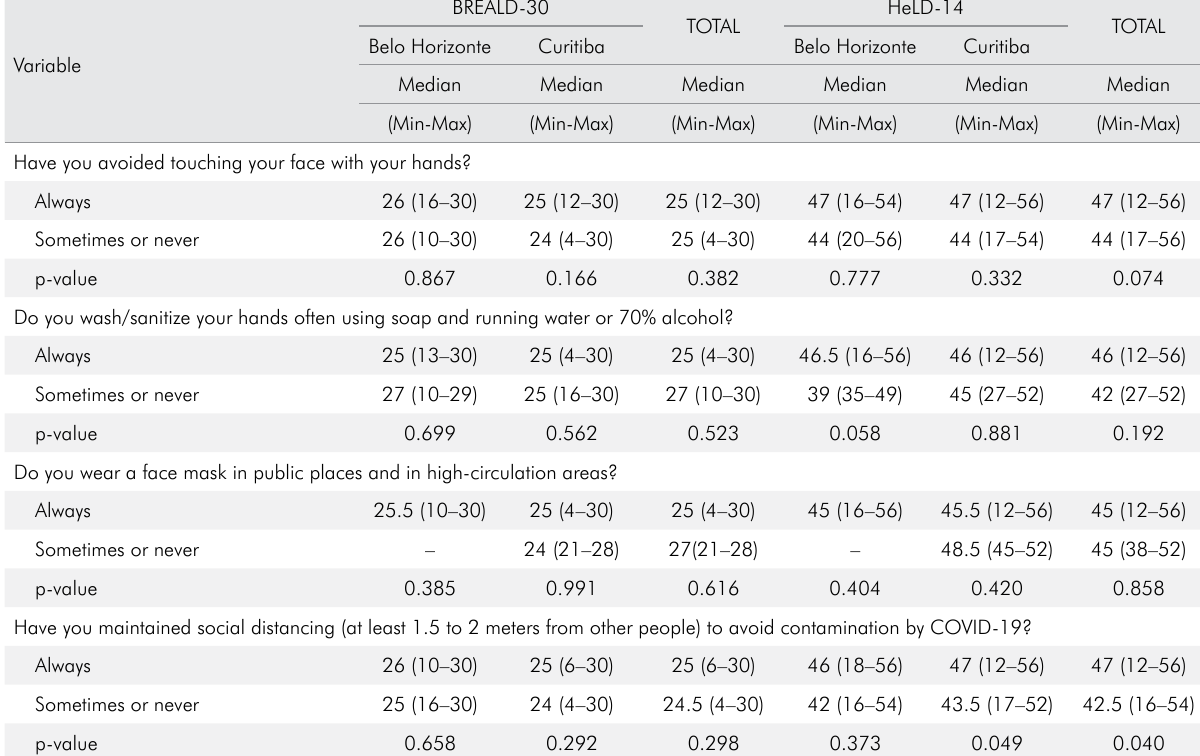
Table 3. Associations between level of OHL measured by BREALD-30 and HeLD-14 and behaviors related to COVID-19 in the cities of Belo Horizonte and Curitiba,